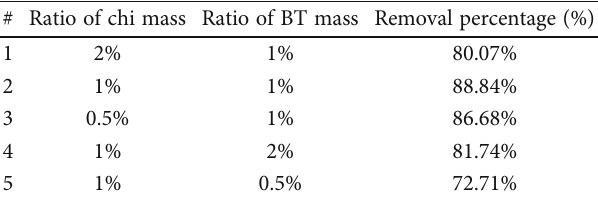
Table 2: Removal percentages of di ff erent CS/BT